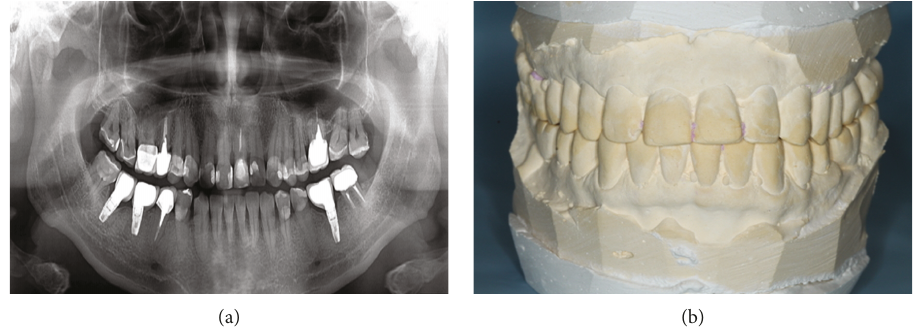
Figure 2: (a) Initial X-rays. (b) Initial study